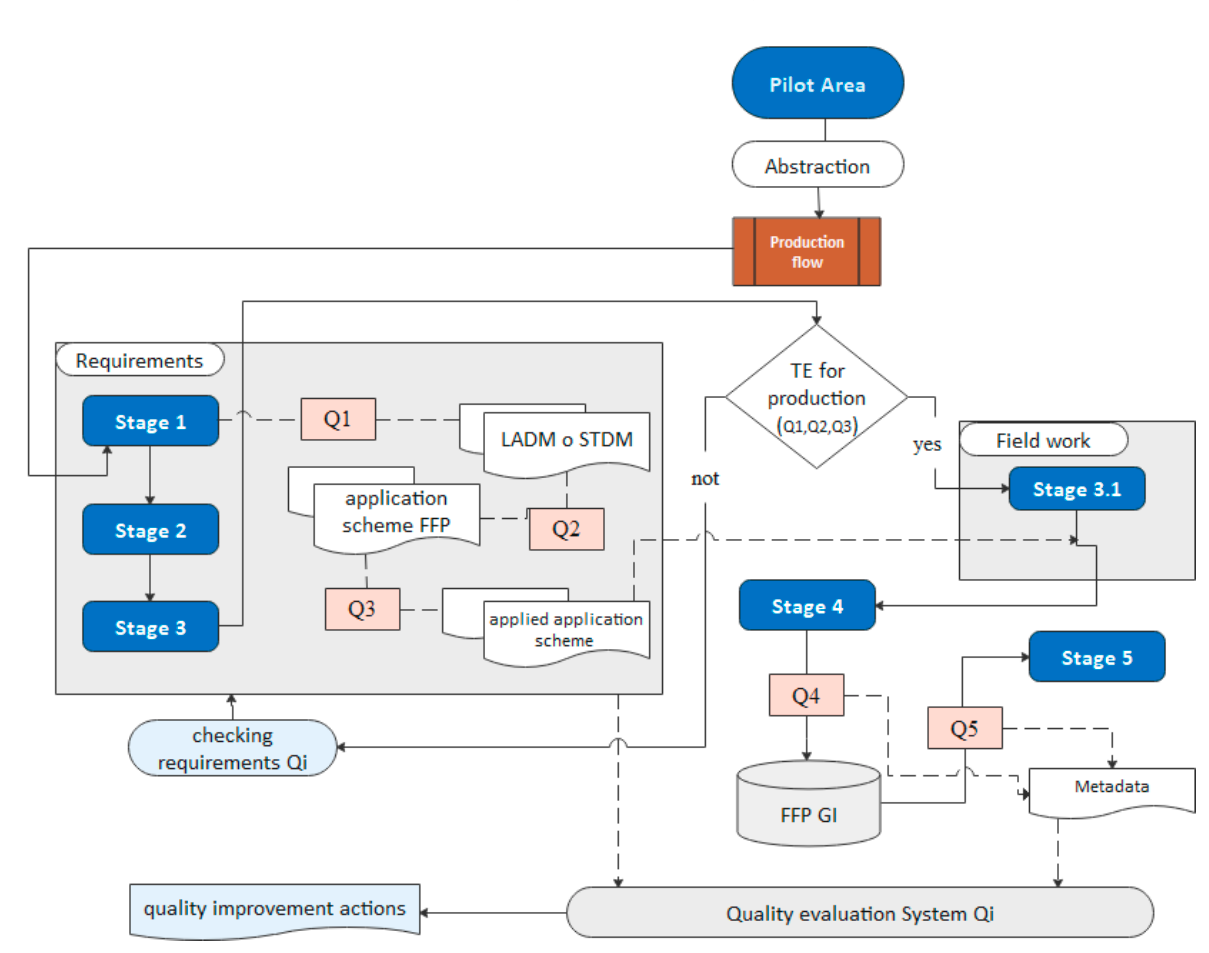
Figure 1. Fit for Purpose (FFP) quality assurance model.